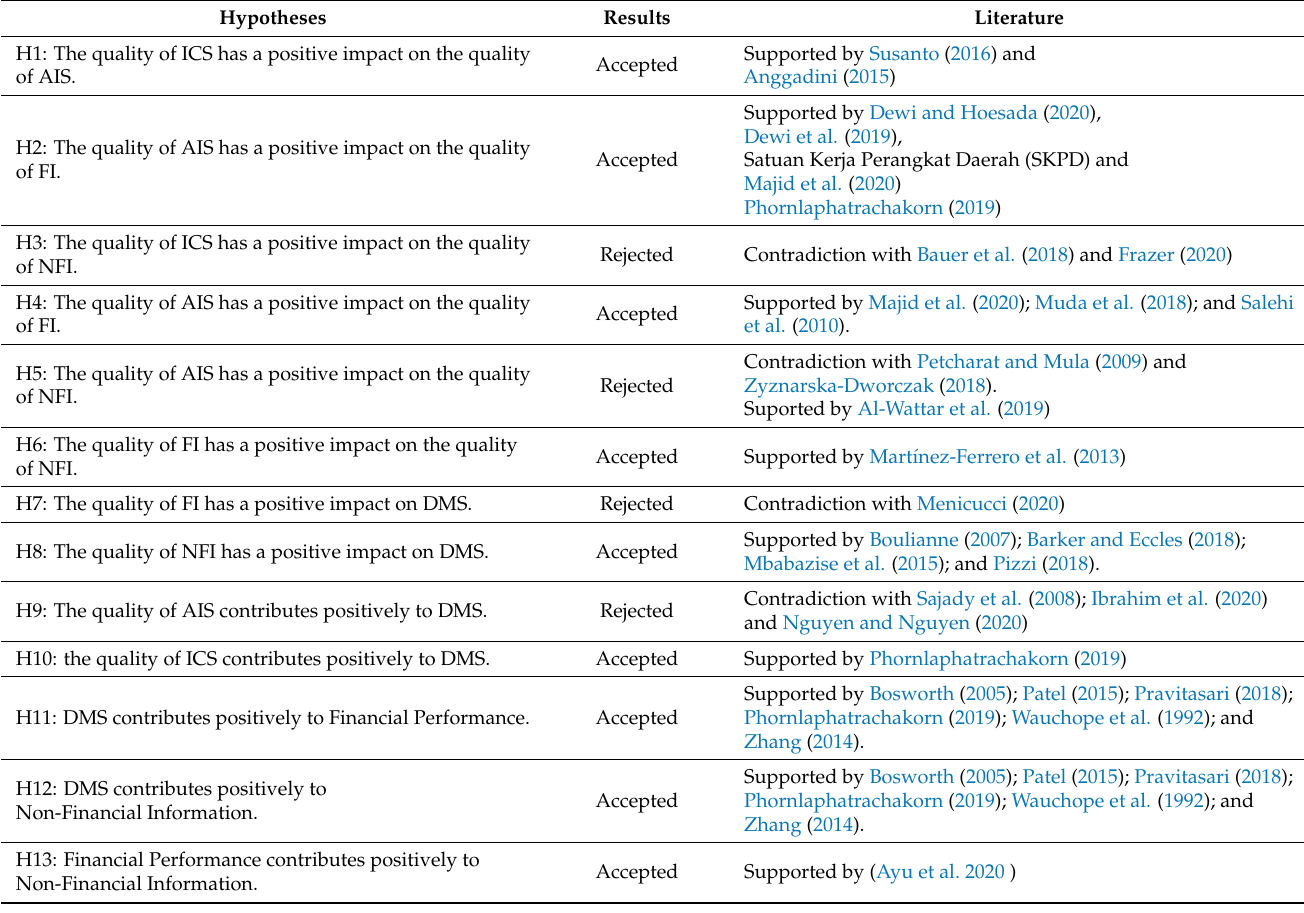
Table 6. Comparing results and